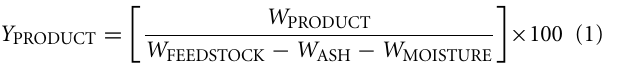
G2858A) with a column (5A PLOT) of 10 m × 0.32 mm size and using Helium as mobile